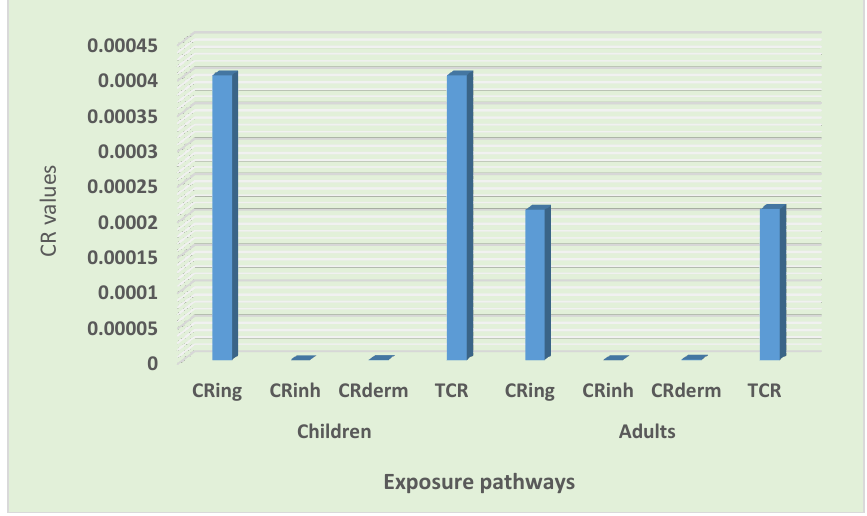
Figure 8. Contribution of exposure pathway carcinogenic risks.